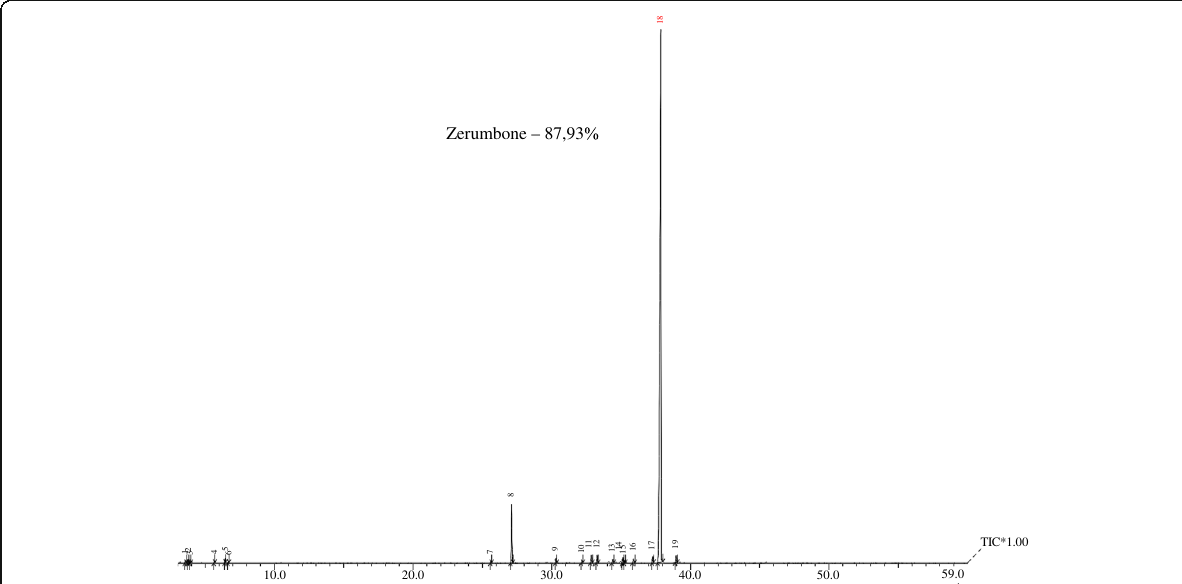
Fig. 2 Gas Chromatography-Mass Spectrometry (GC-MS) of Essential oil Zingiber zerumbet (L.) Smith. Analysis revealed the presence of 19 compounds. Zerumbone was the major compound (87,93%) found in the essential oil used in this study.* R. time: retention